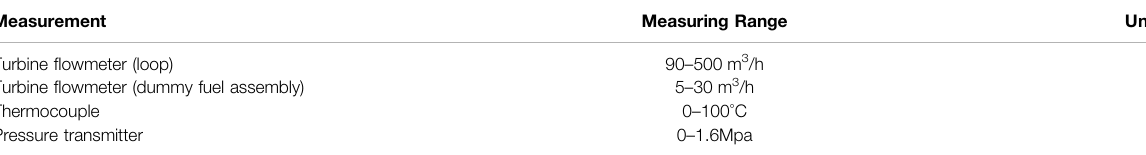
TABLE 3 | Measuring range and uncertainty.